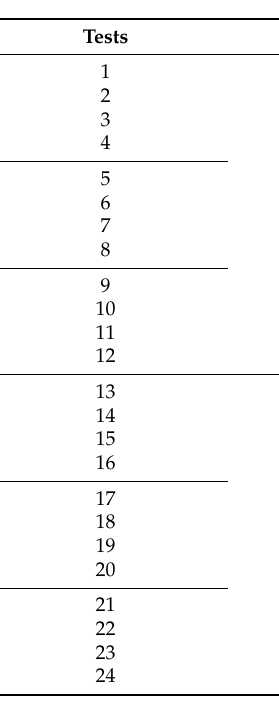
Table 6. Experimental design tests in industrial